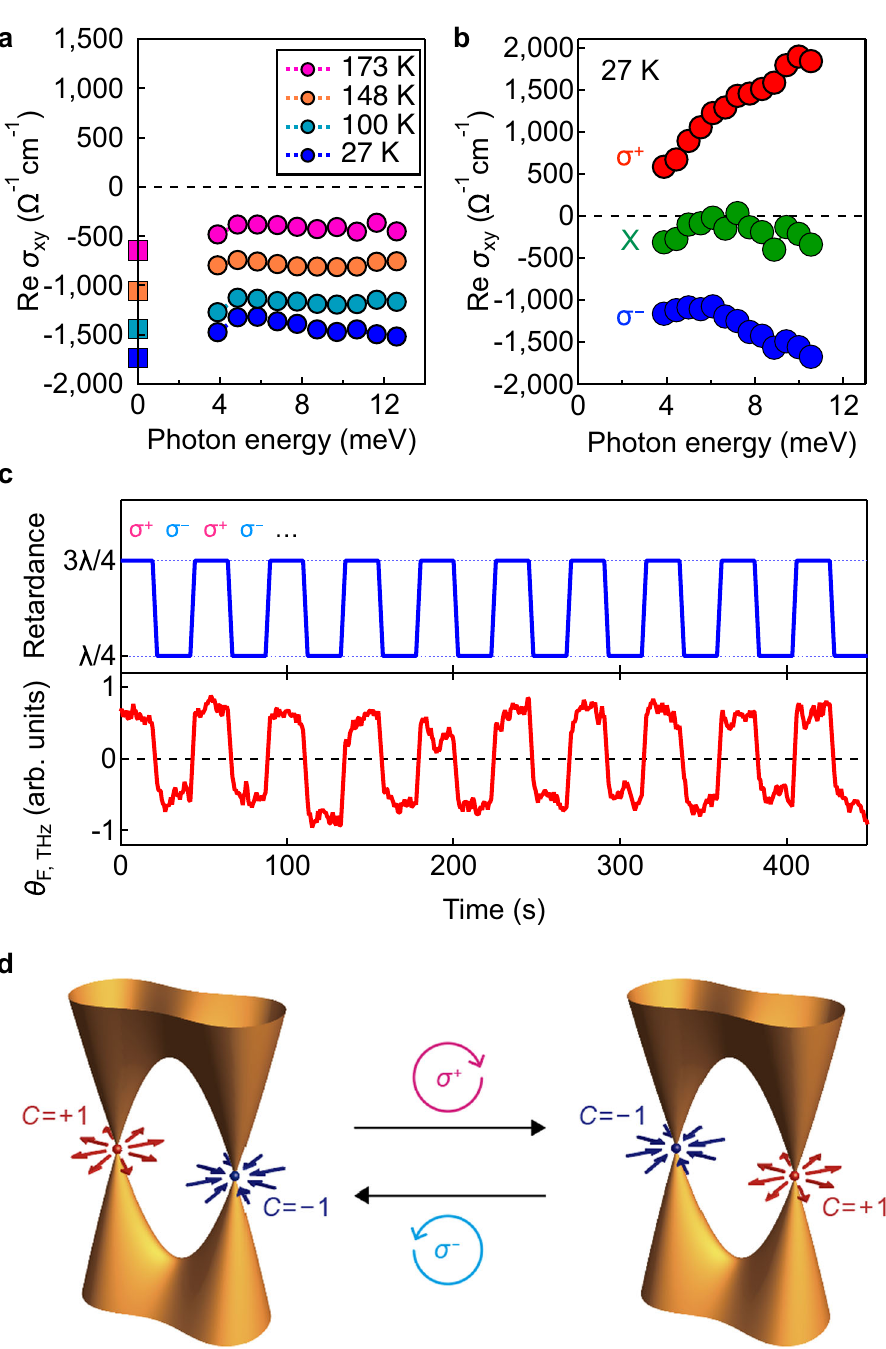
Fig. 2 Non-volatile, repetitive switching of anomalous Hall conductivity. a Optical anomalous Hall conductivity (AHC) (circles at several temperatures) of the uniformly magnetized fi lm by fi eld-cooling. Squares indicate the AHC measured by dc transport. b Optical AHC after sweeping the mid-infrared (MIR) pump pulses with the σ (cid:1) , σ þ , and X polarization. c Temporal evolution of terahertz (THz) Faraday rotation angle θ F ; THz under MIR pulse excitation with the fl uence of 1.99 mJ cm − 2 , along with the retardance of the waveplate where λ = 4 (3 λ = 4) corresponding to σ (cid:1) ( σ þ ) polarization. The sample temperature was set to 148 K by zero- fi eld cooling, so the initial magnetization was M / M 0 = 0 (multi-domain state). d Illustration of chirality switching of magnetic Weyl semimetals (MWSMs) by circularly polarized light. The chirality of each Weyl point is described as C = ±